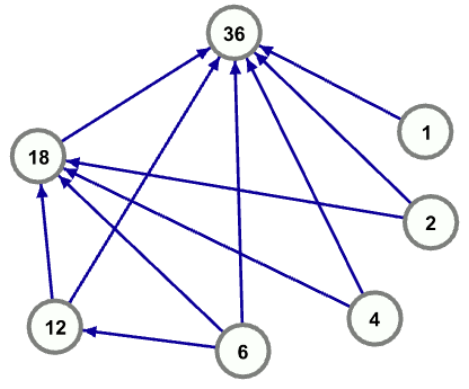
Figure 1. Divisor graph for λ = 36.